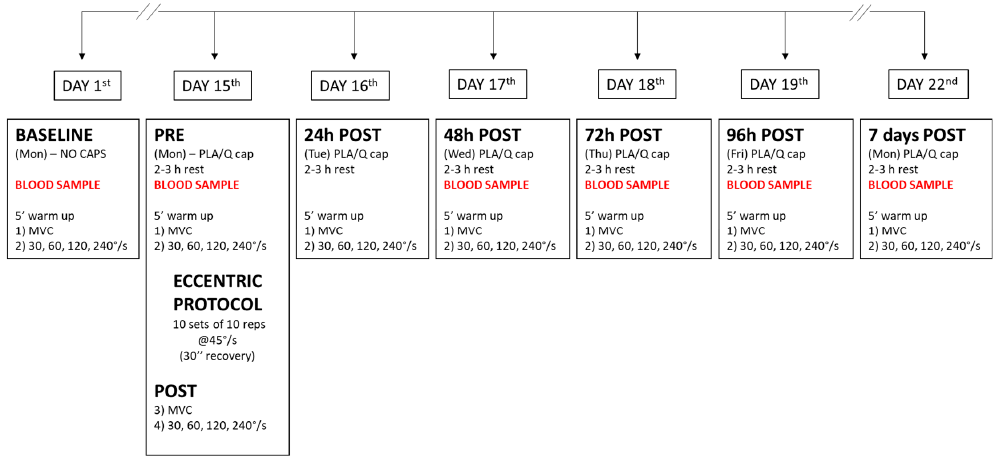
Figure 1. Diagram of the research design. BASELINE: baseline measurements before treatment; PRE: pre-test; MVC: maximal voluntary contraction; POST: post-test; PLA: placebo; Q: